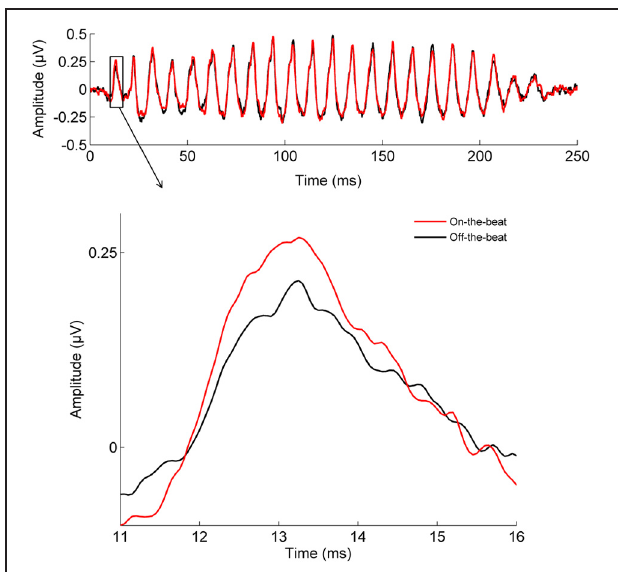
FIGURE 2 | The effect of musical rhythm on subcortical sound processing. The brainstem wave V onset response is enhanced when a target sound is aligned with the beat of the music, rather than shifted away from the beat (paired t -test, t = 2 . 86, p < 0 . 01).